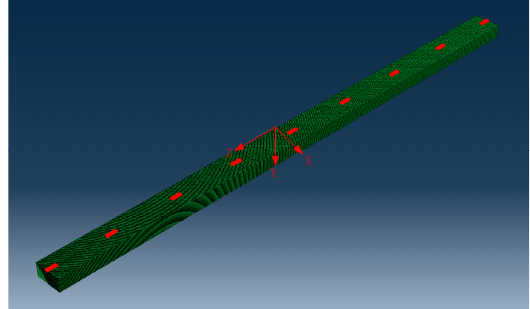
Figure 4. Finite element model of stator insulation structure.